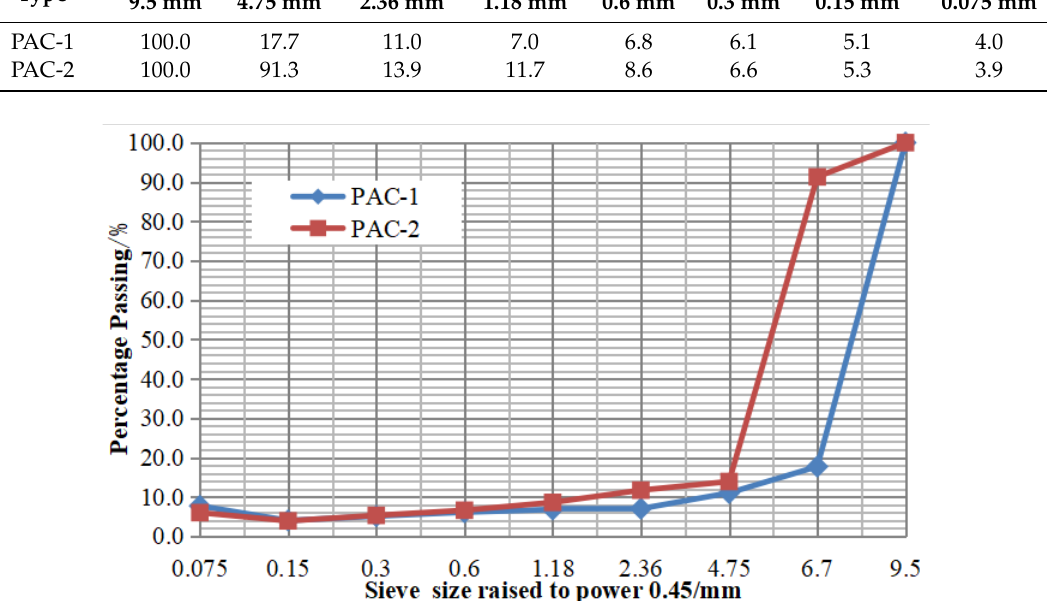
Figure 4. Grading curves of two porous asphalt concretes (PACs).